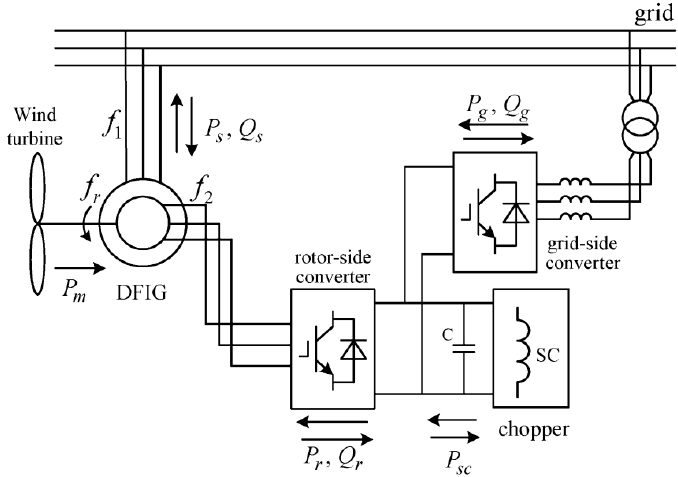
Figure 10. Configuration of doubly-fed induction generator (DFIG) wind power system based on superconductive magnetic energy storage (SMES). Reprint with permission [88]; Copyright 2011, IEEE.